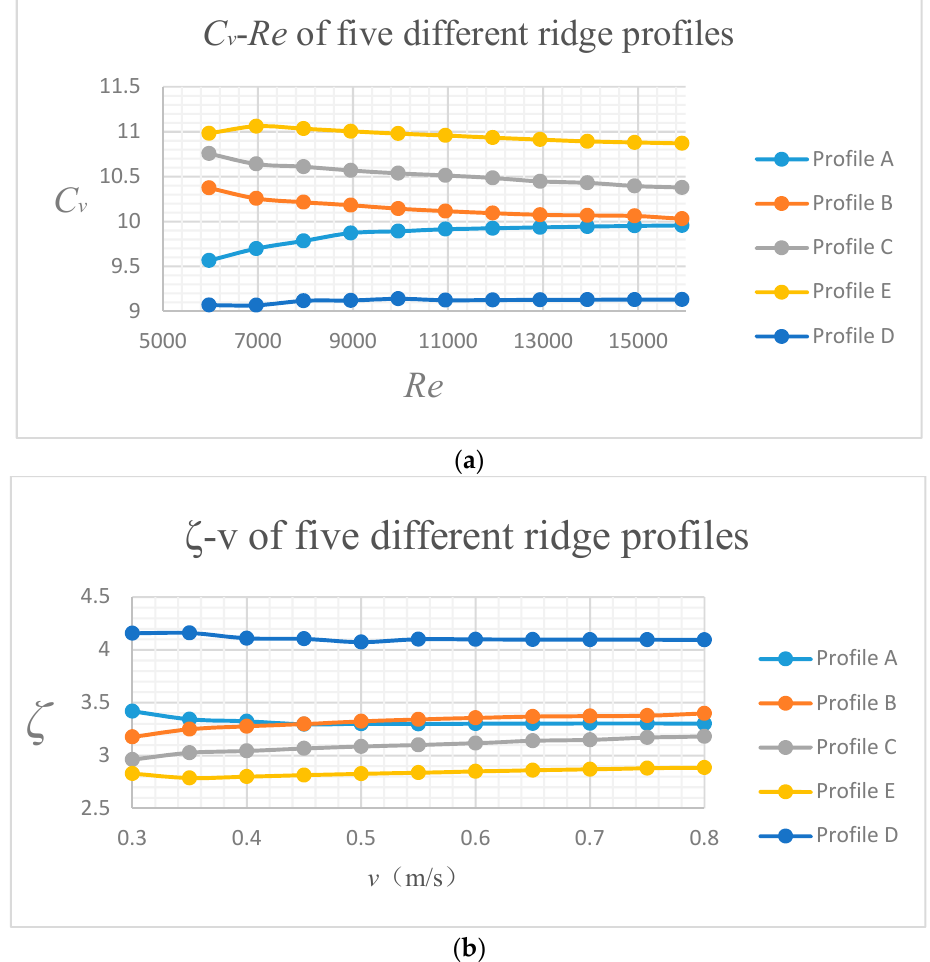
Figure 11. The results of the Comparison of Throttling Characteristics of Five Profiles. ( a ) C v - Re of five different ridge profiles; ( b ) ζ - v of five different ridge profiles.